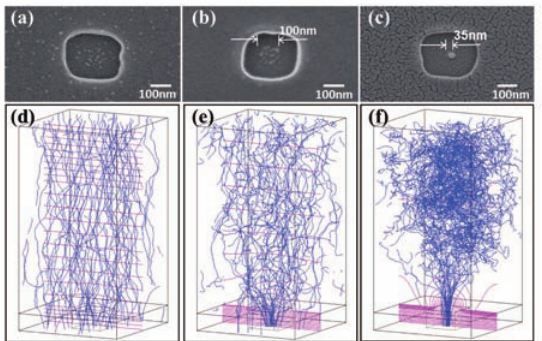
Fig. 5 The focusing effect dependent on the surface charge density of the substrate prepatterned with a 135-nm thick photoresist having 230-nm square openings. (a)-(c) Experimental results. Reprinted with permission from ref 46. Copy- right 2006 Nature Publishing Group. (d)-(f) Simulation results of the trajectories of nanopar- ticles and the equipotential lines in three di- mensions. Reprinted from ref 90. Copyright 2007, with permission from Elsevier. Surface charge densities are increased from 3.6 × 10 -